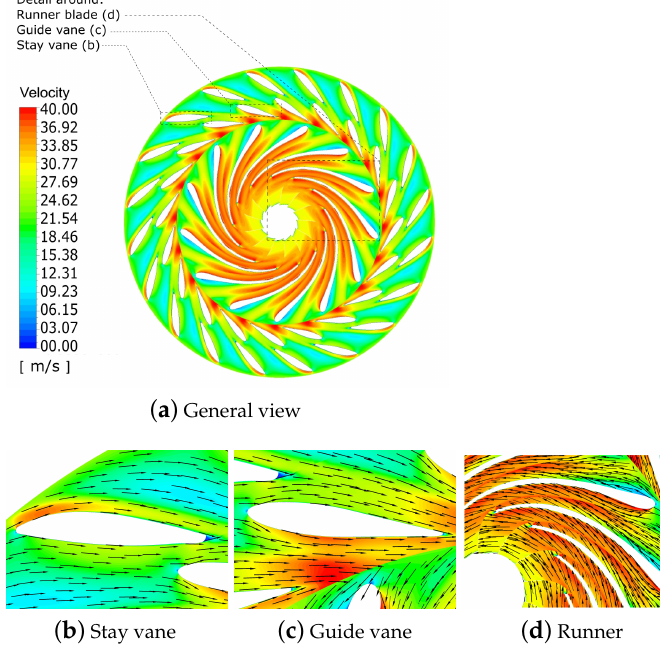
Figure 10. Velocity distribution in flow components at the best efficiency point.